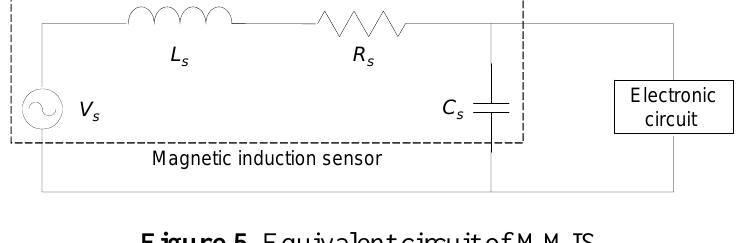
Figure 5. Equivalent circuit of MMIS.